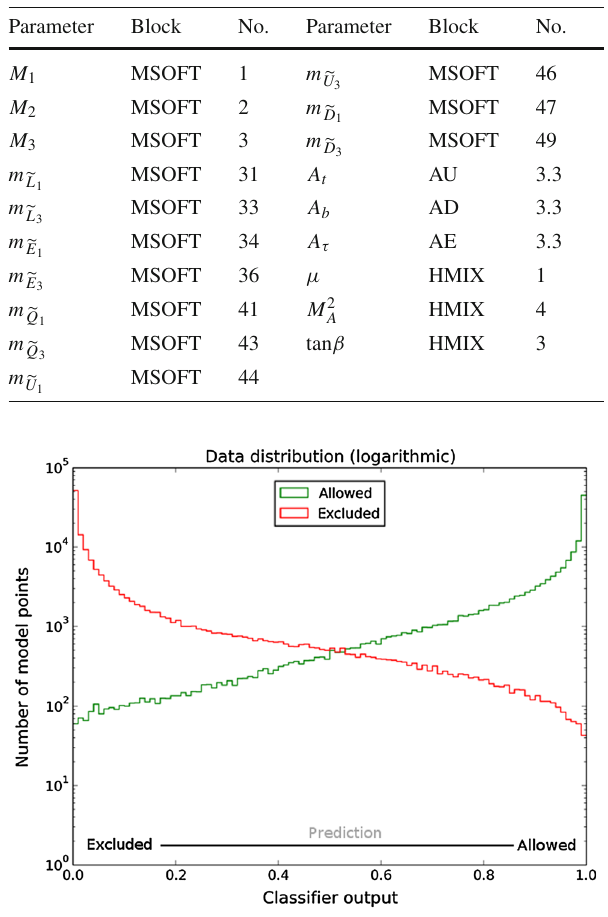
In order to find an optimal configuration of the classifier,